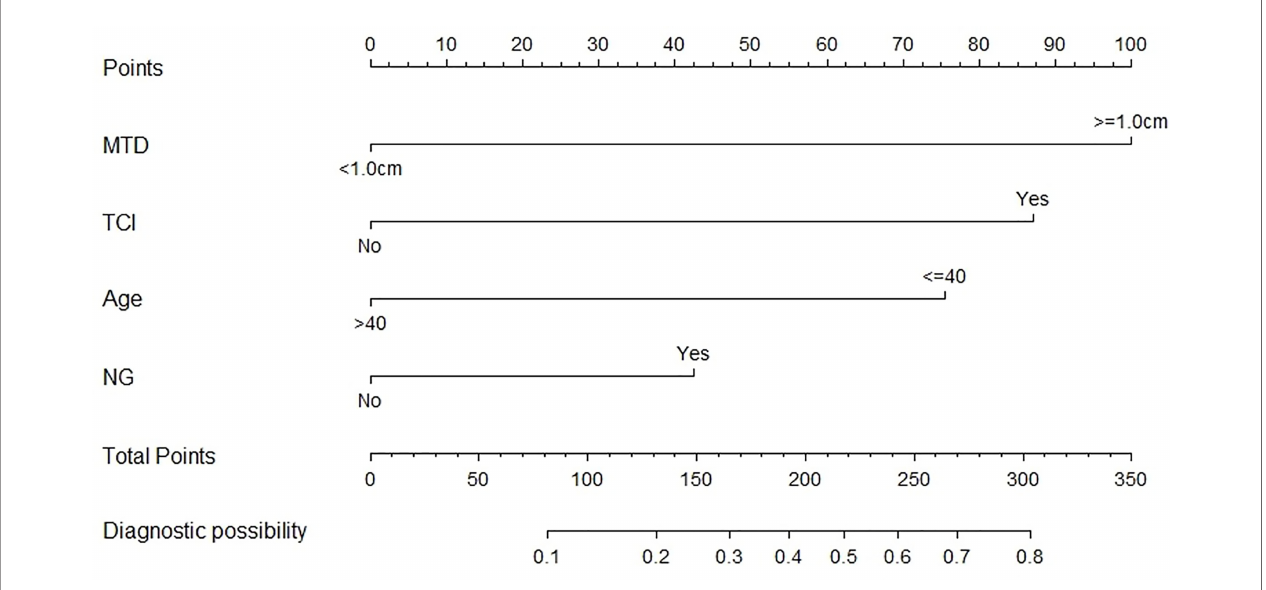
FIGURE 2 | The risk-scoring model for predicting LLNM risk in PTC patients with tumor located in upper